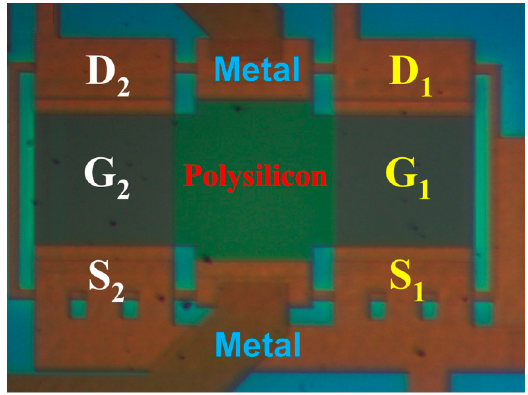
Figure 15. Microphotograph of the proposed strip MAGFET comprising two separated MOSFETs and a differential polysilicon cross-shaped Hall plate (CSHP).